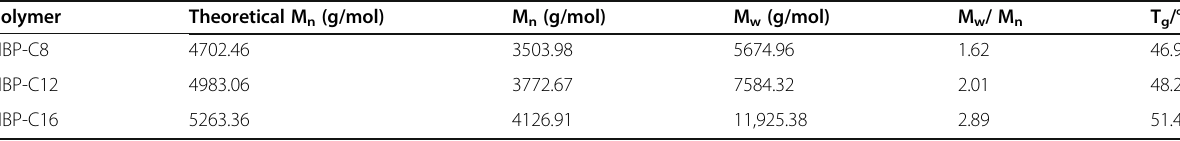
Table 2 GPC results of HBP-C